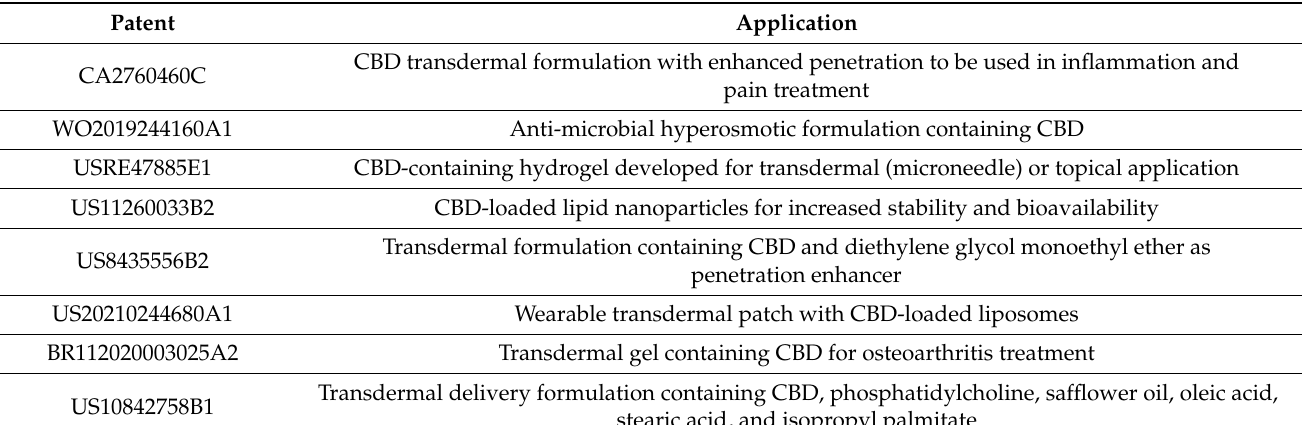
Table 4. Examples of patented formulations aiming CBD use in skin care products or in lipidic particle